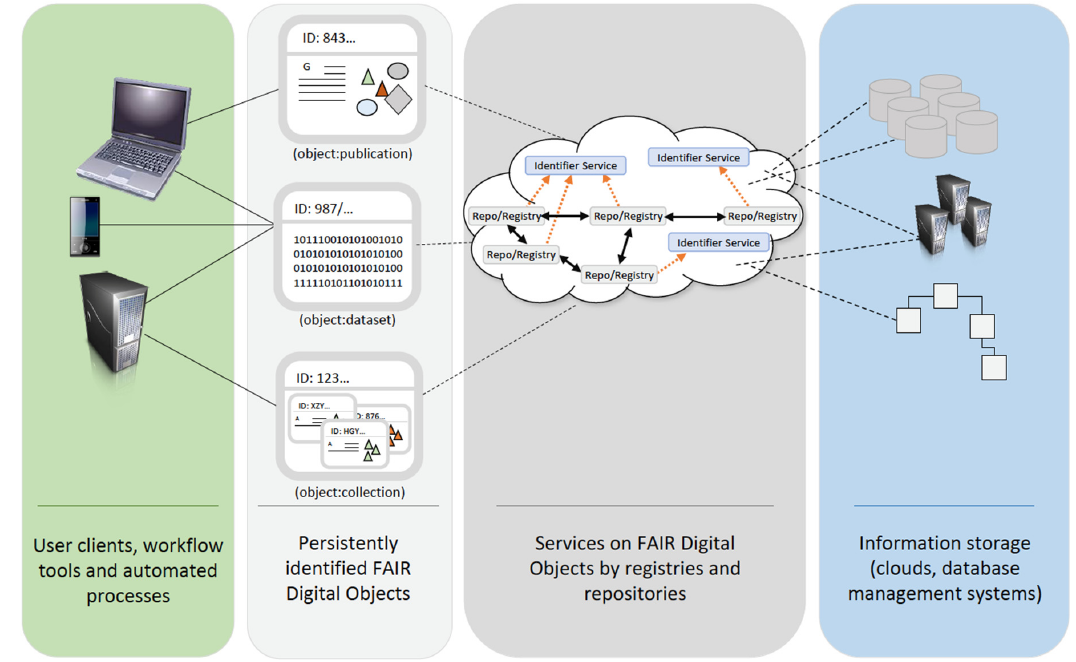
Figure 2. Layers of abstraction in the data domain.